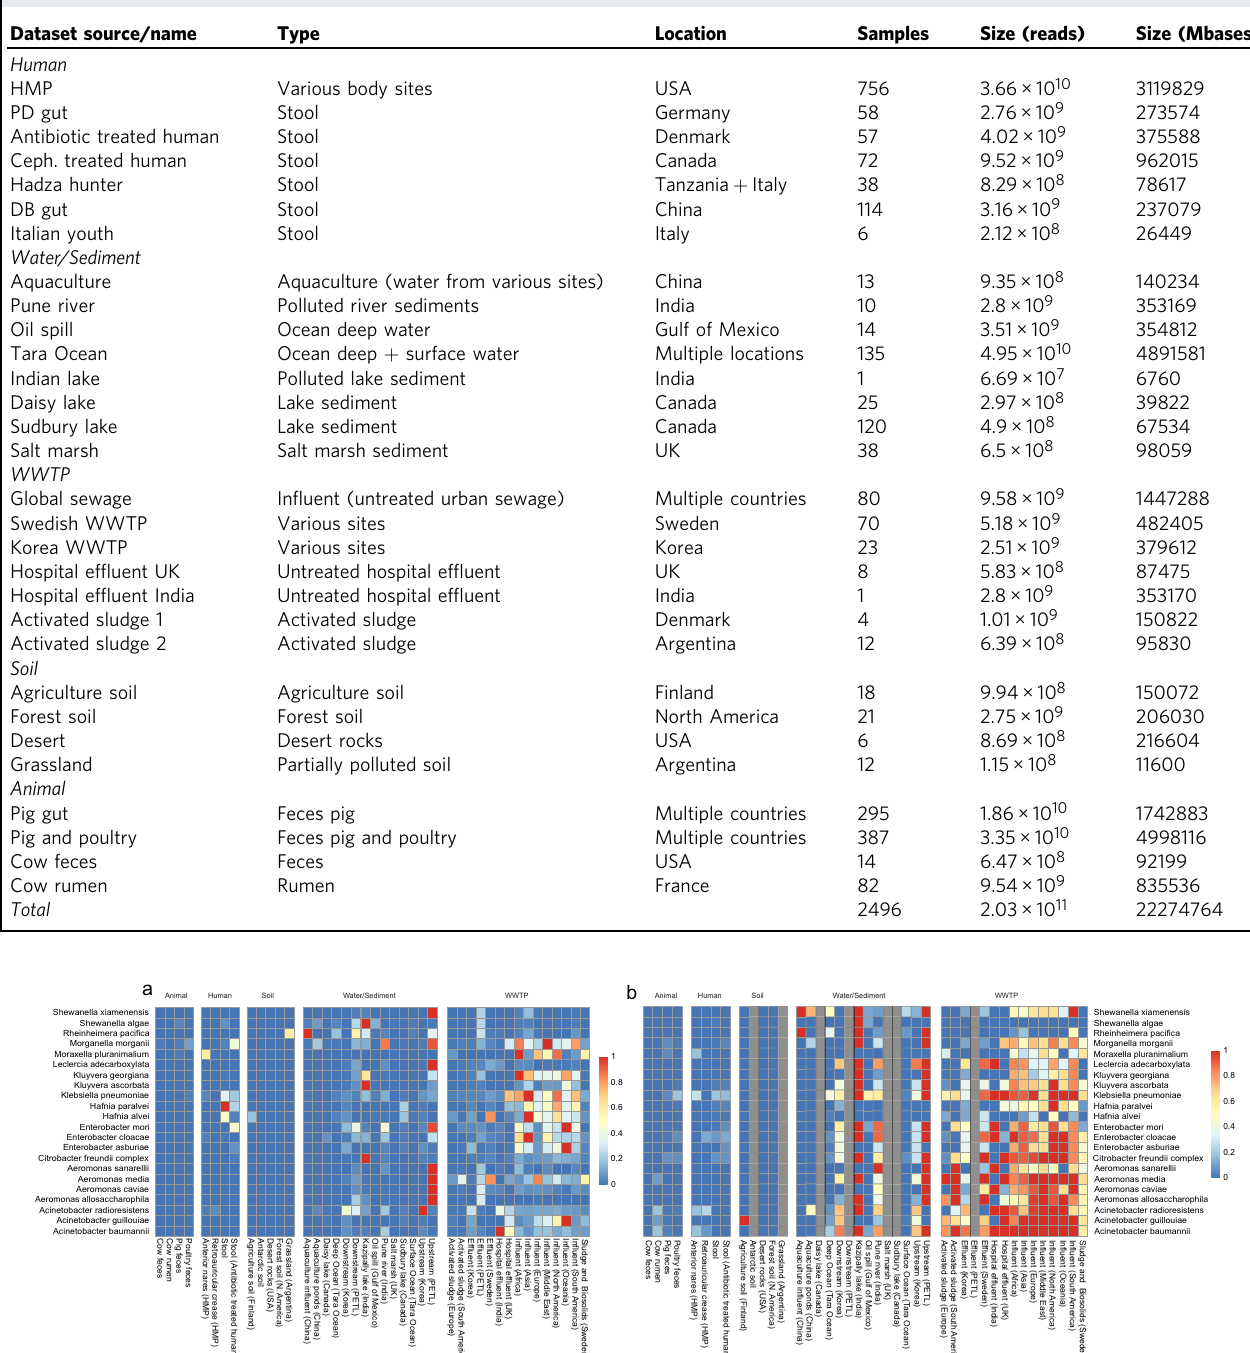
Table 2 The analyzed datasets.